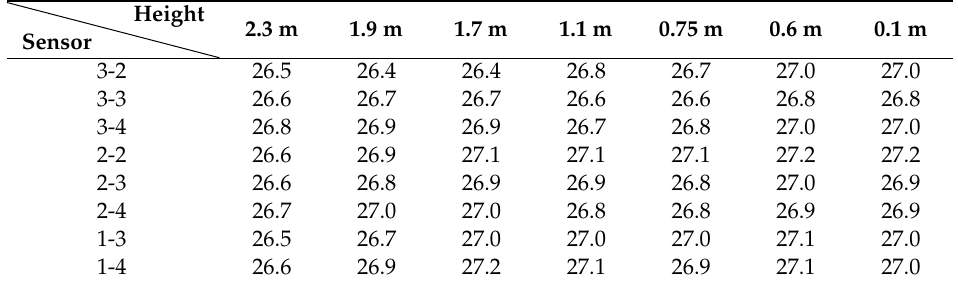
Table 5. Indoor temperature at di ff erent levels under condition A.